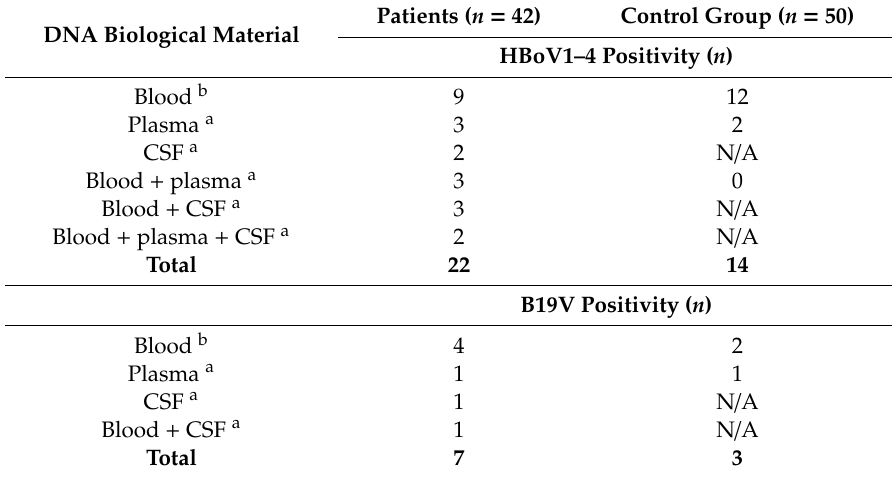
Table 2. The presence of human bocaviruses 1-4 (HBoV1–4) and parvovirus B19 (B19V) genomic sequences among patients and control group.